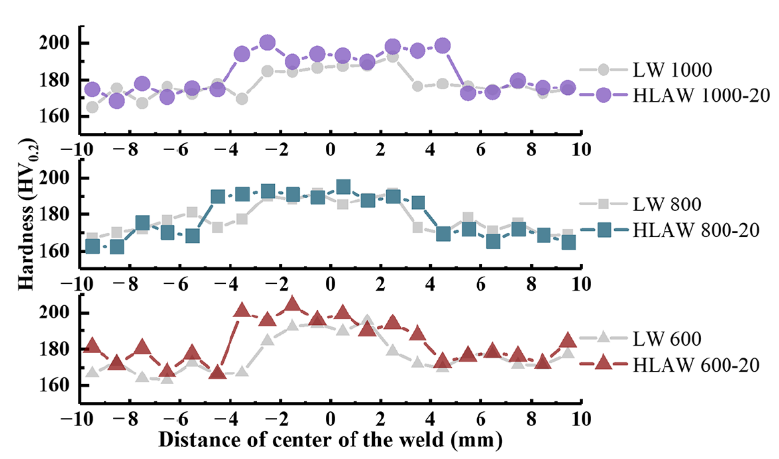
Figure 10. Microhardness distribution of weld